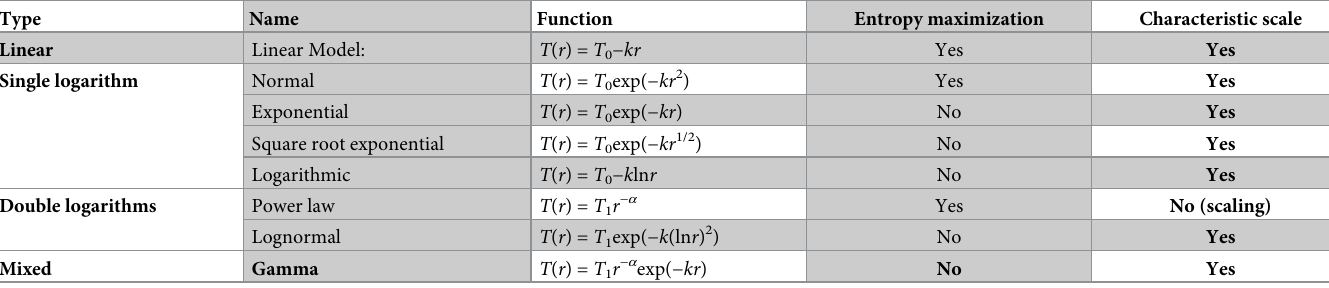
Table 4. The common distance decay functions in geographical analyses and its mathematical and physical